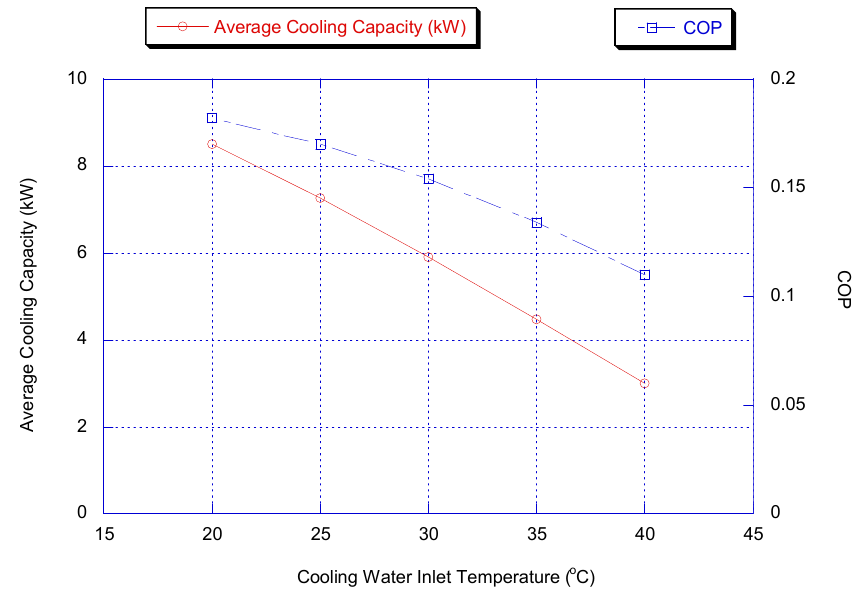
Figure 12. Effect of cooling water inlet temperature on chiller average cooling capacity and COP without heat recovery (results are at optimum parametric values, shown in Appendix B).